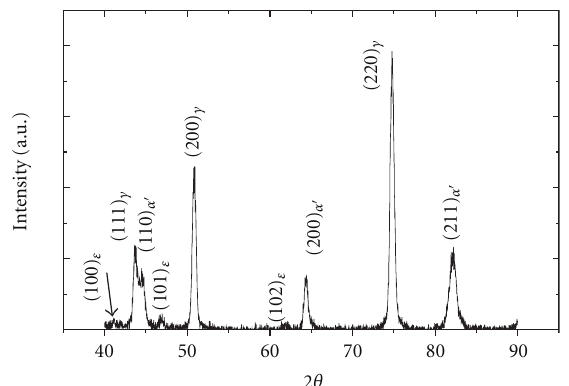
Figure 2: X-ray di ff raction spectrum of sample deformed of 0.06 at − 10 ◦